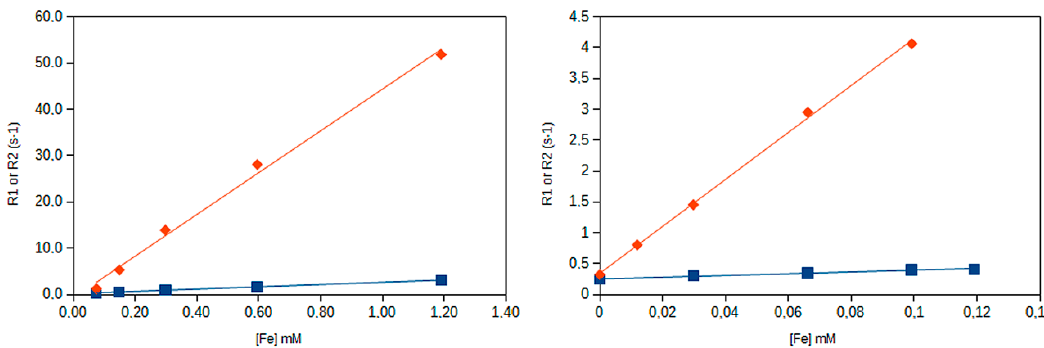
Figure 3. Variation of the longitudinal (R1, blue squares) and transverse (R2, red diamonds) relaxation